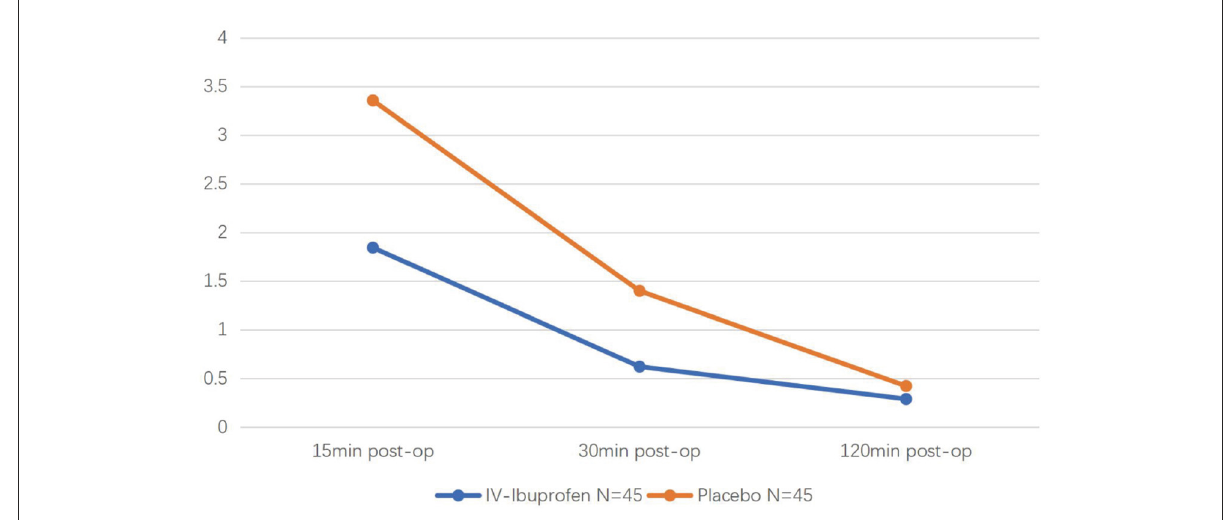
FIGURE2 The Faces, Legs, Activity, Cry, and Consolability (FLACC) scale during the 2h postoperative period of two groups.